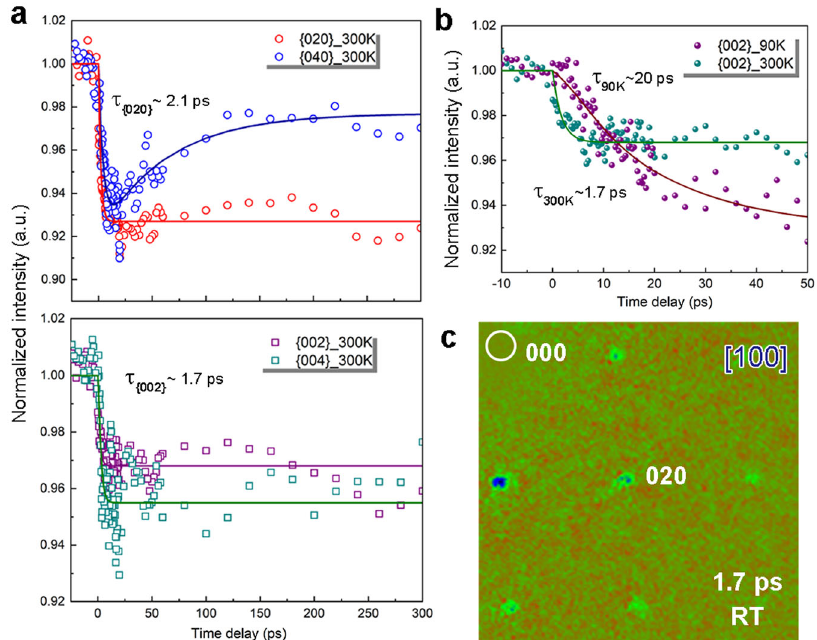
Fig. 3 UED experimental observation at 300 K. a Temporal evolution of the normalized diffraction intensity I / I 0 of Bragg peaks {020}, {040}, {002} and {004} at 90 K. b Comparison of the intensity changes of Bragg peaks {002} at 90 and 300 K. The intensity drops faster at 300 K, i.e., time constant τ 300K ~1.7 ps < τ 90K ~20 ps. c The isotropic distribution around each Bragg peak in the intensity difference map at 300 K at 1.7 ps after laser